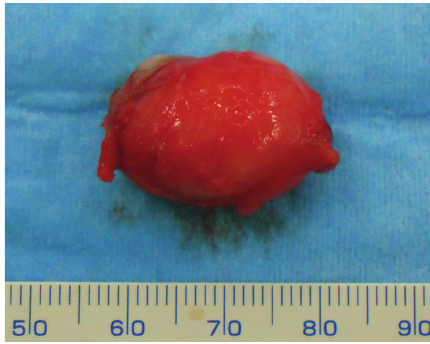
Figure 3: Gross appearance of the lesion. The excised specimen was pinkish in color, displayed a soft consistency, and measured 20 × 15mm in